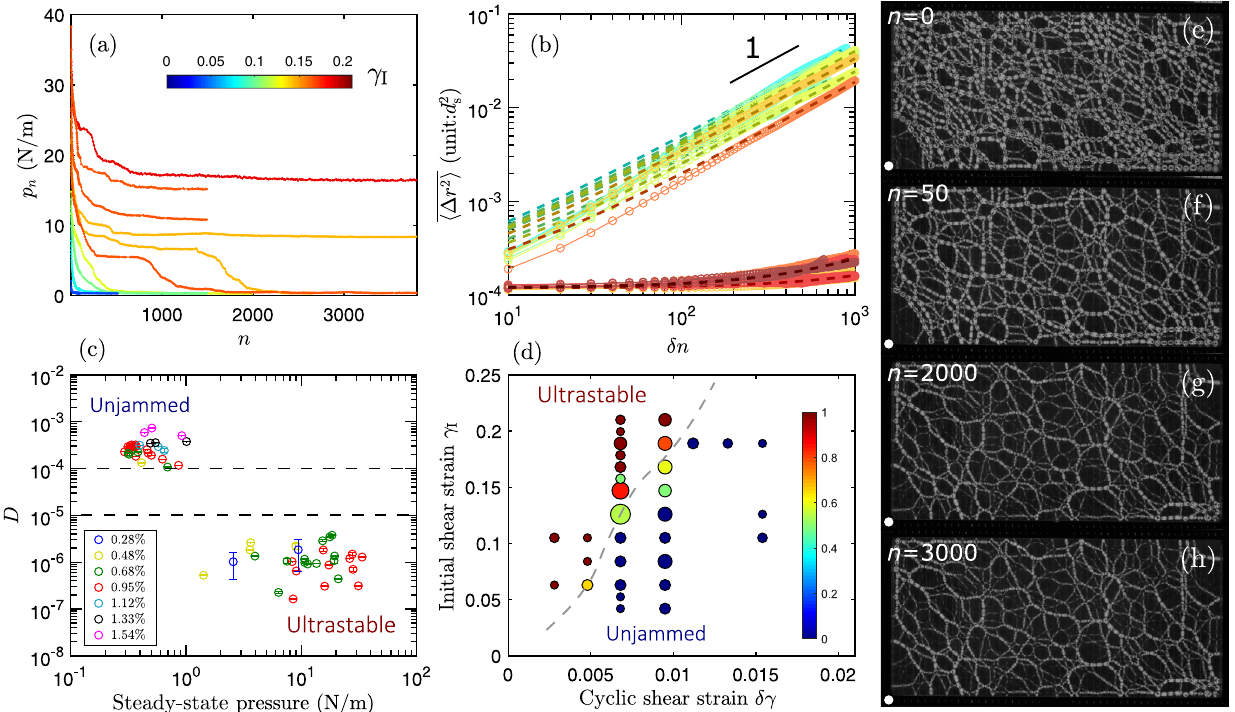
FIG. 2. (a) The pressure measured after n full shear cycles, p , as functions of shear cycle number n for several example experiments n used to with the same cyclic shear strain amplitude δγ ¼ 0 . 95% . The color of each curve in (a) and (b) labels the initial shear strain γ I create the original shear-jammed states, according to the color bar in (a). (b) The mean square displacements of particle centers only in , where d is the diameter of our small the steady-state regimes for several example experiments with the same δγ ¼ 0 . 95% . The unit is d 2 s s disk. The dashed lines are linear fits on individual curves with the form defined in Eq. (3). (c) The diffusion coefficient D obtained by the fits using Eq. (3) for the steady states formed by different γ and δγ plotted versus the pressure of these steady states. The color of the I markers labels the δγ value used to form these steady states. (d) The frequency of the observation of ultrastable states under different control parameters γ and δγ for about a hundred independent experiments, each containing thousands of shear cycles. The size of each I circle labels the number of experiments performed using the same ( δγ , γ ), with the smallest and the largest corresponding to 1 and 9 I realizations, respectively. The color of each circle labels the number fraction of experiments that an ultrastable state is observed, following the inserted color bar. The dashed curve sketches the boundary that separates the ultrastable states and the unjammed states as the outcome of cyclic shearing. (e) – (h) are snapshots of experiments showing the photoelastic patterns of an example experiment with γ ¼ 0 . 147 and δγ ¼ 0 . 95% after 0, 50, 2000, and 3000 shear cycles, respectively. Note that if the photoelastic patterns are the same for I two packings, then the positions of particles and the contact forces between particles are all the same. The white circles at the lower left corner of each panel have the same diameter as our bigger disk (15.9 mm) and serve as scale bars for images in (e) –